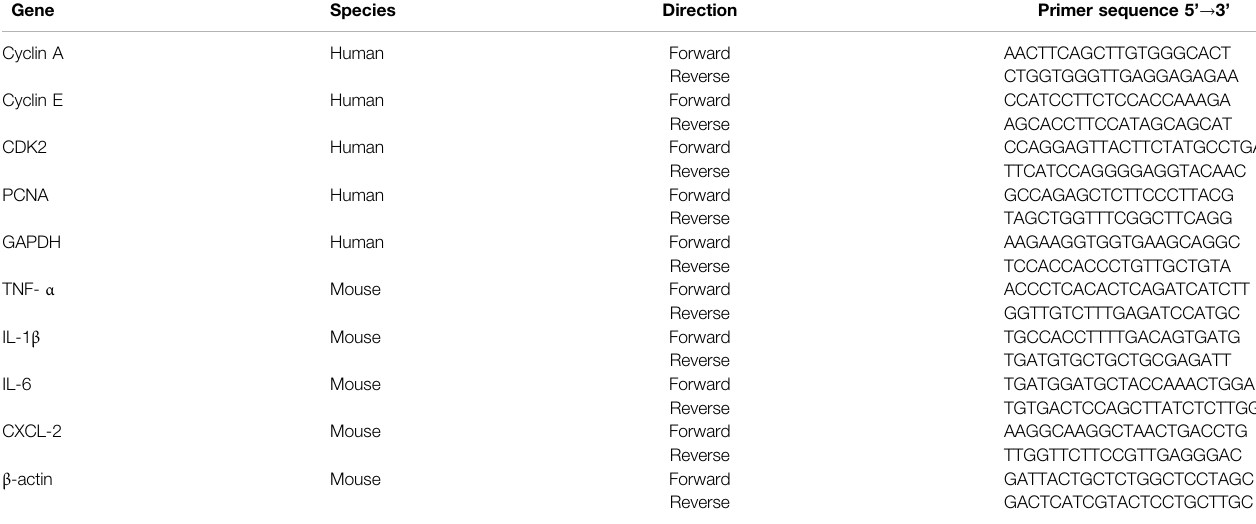
TABLE 1 | Sequence of primers for